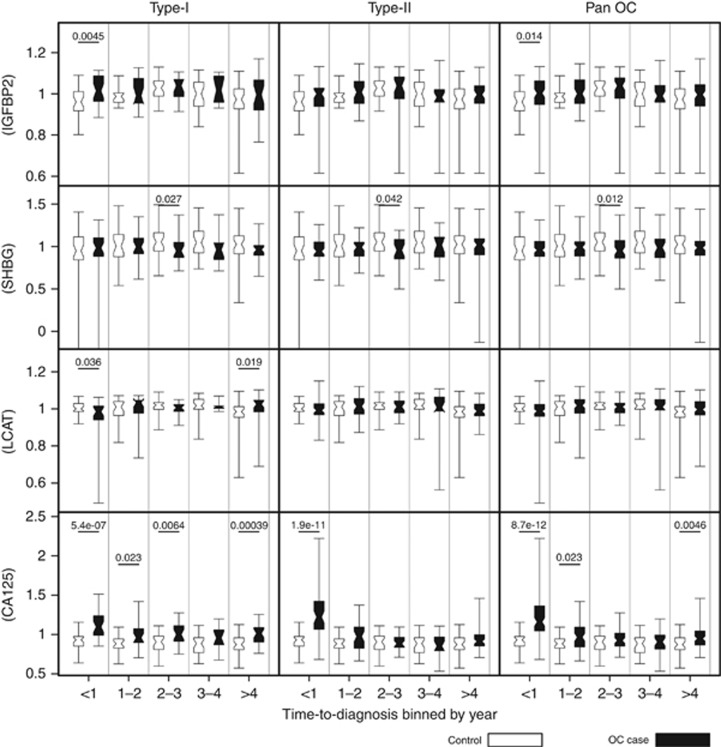
Comparison of putative biomarker expression in pre-diagnosis sets, divided into yearly intervals. The whisker limits represent the 5th and 95th percentiles; the box limits represent interquartile range; the closest point in the notches (><) of the box plot represents the median and the span from the bottom to the top of the notch is 95% confidence interval (for significant values between cases and controls it can be seen that these do not overlap). Significant P-values are indicated on the plot.